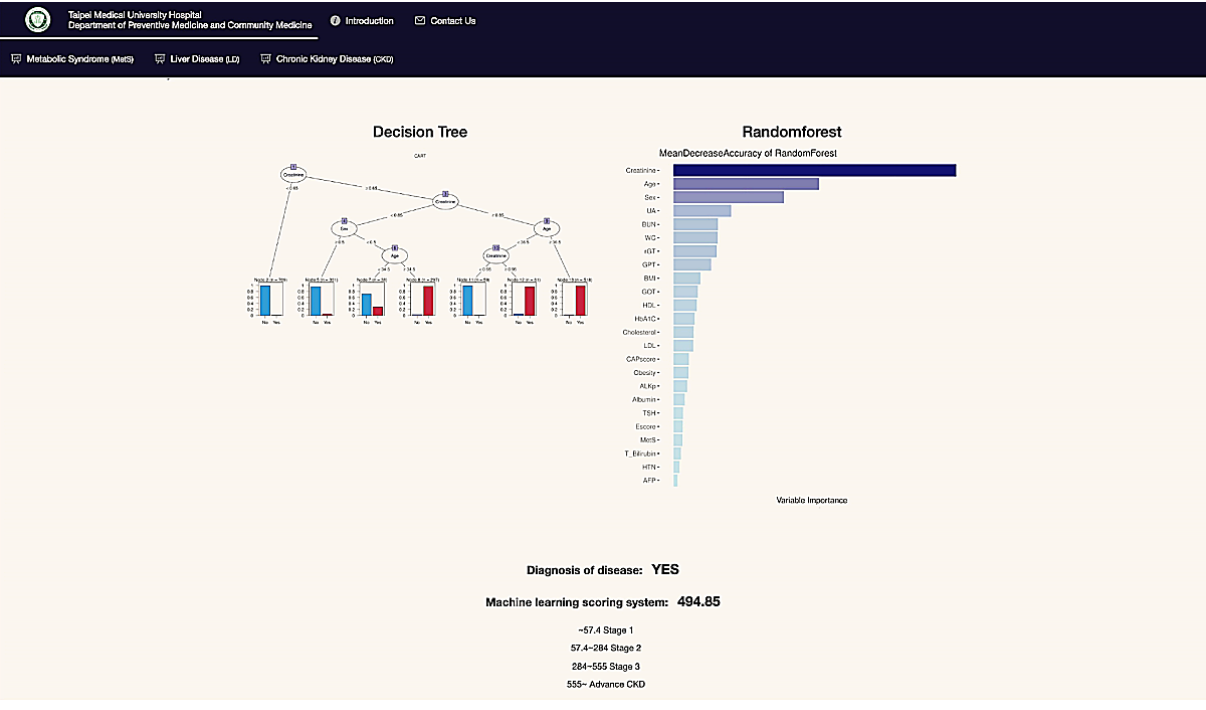
Figure 5. Outcome page for supervised learning models and the scoring system for disease